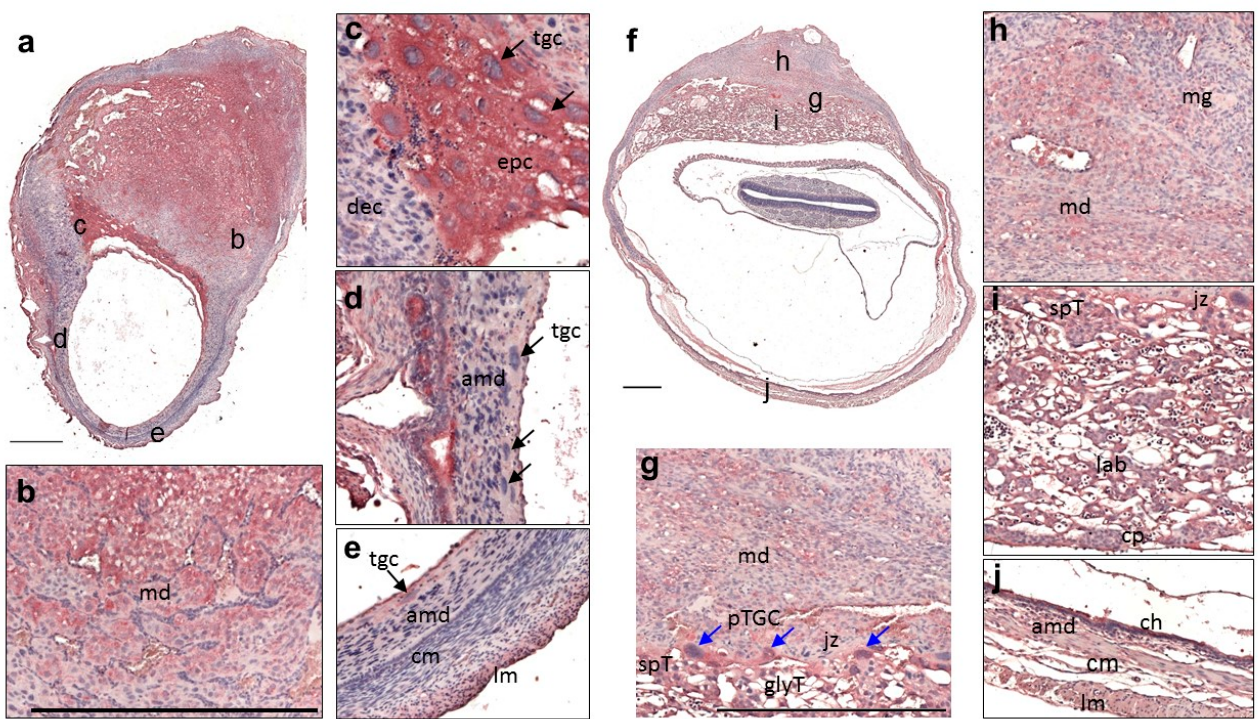
Figure 2. Expression of QSOX1 in the pregnant uterus and placenta at 9.5 and 11.5 dpc. ( a ) Representative image of immunohistochemical staining of QSOX1 in the pregnant uterus at 9.5 dpc. ( b – e ) Enlarged views of the marked area in ( a ). ( f ) Representative image of immunohistochemical staining of QSOX1 at 11.5 dpc. ( g – j ) Enlarged views of the marked area in ( f ). The blue arrow indicates the parietal trophoblast giant cells. Red colors show QSOX1 staining, and blue shows the counterstain of hematoxylin in the nucleus. Scale bar = 500 μ m. Abbreviations: amd, anti-mesometrial decidua; ch, chorion; cm, circular muscle; cp, chorionic plate; dec, decidua; epc, ectoplacental cone; glyT, glycogen trophoblast; jz, junction zone; lab, labyrinth; lm, longitudinal muscle; md, mesometrial decidua; mg, mesometrial gland; pTGC, parietal trophoblast giant cell; spT, spongiotrophoblast; tgc, trophoblast giant cell.